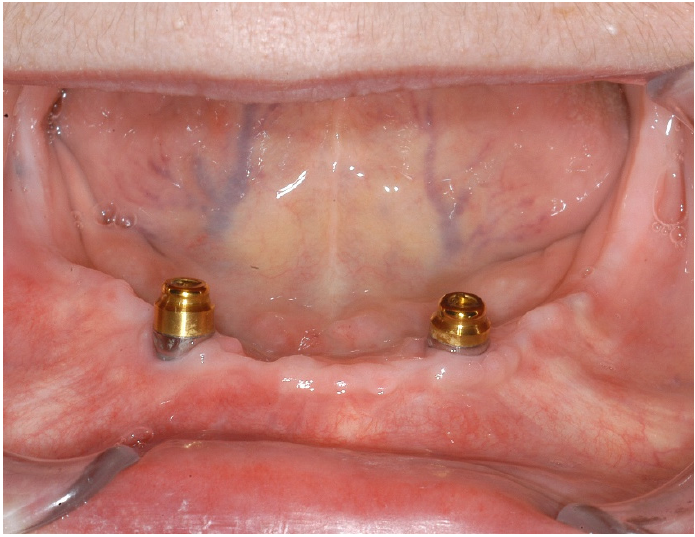
Figure 8. Clinical situation after one year.